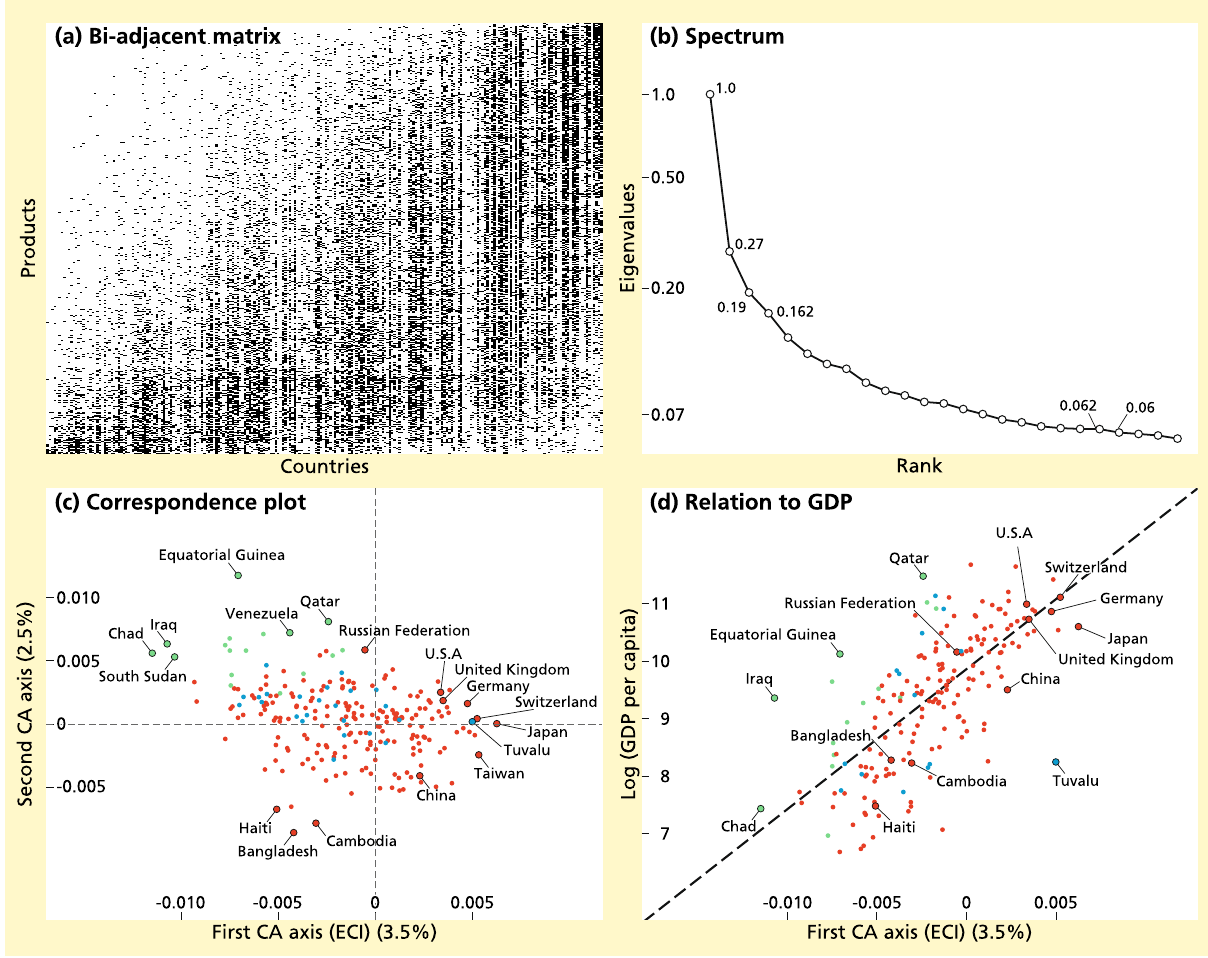
Figure 3. Results of applying CA to the country-product matrix. (a) : The country-product incidence matrix shows a triangular structure. Column and rows are sorted by the first CA axes, known as ECI and PCI for the country and the product similarity matrices, respectively. (b) : Sorted spectrum for the country-product matrix (log-scale). The slow decay and lack of clear gaps in the spectrum suggests a high-dimensional, homogeneous dataset. Numerical labels are reported for the first four eigenvalues, and for the twenty-first and twenty-second (the small gap between the latter two motivated the choice of a twenty-dimensional embedding in the final part of the analysis) (c) : Correspondence plot showing the first (horizontal) and second (vertical) CA axes for the country similarity matrix. The first CA axis is known as the ECI, and explains 3.5% for the total variation. The second axis explains 2.5% of total variation and seems to distinguish countries specializing in garments and 3 on the textiles from other countries. Colors indicate the obtained clusters when running k-Means with K = embedding spanned by the first 20 CA axes. (d) : GDP per capita as a function of the first CA axis (ECI). The 2 dashed line is the linear regression of log ( GDPpc ) with ECI ( R =0.49). Colors indicate the same clusters as in c ). The analysis was performed using our SCCA R package 21